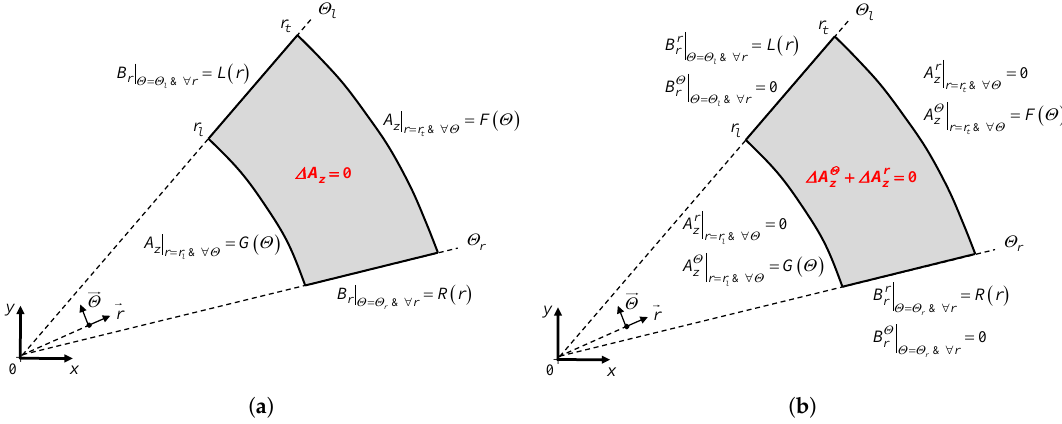
Figure A3. B r imposed on r -edges and A z imposed on Θ -edges of a region: ( a ) general and ( b ) principle of